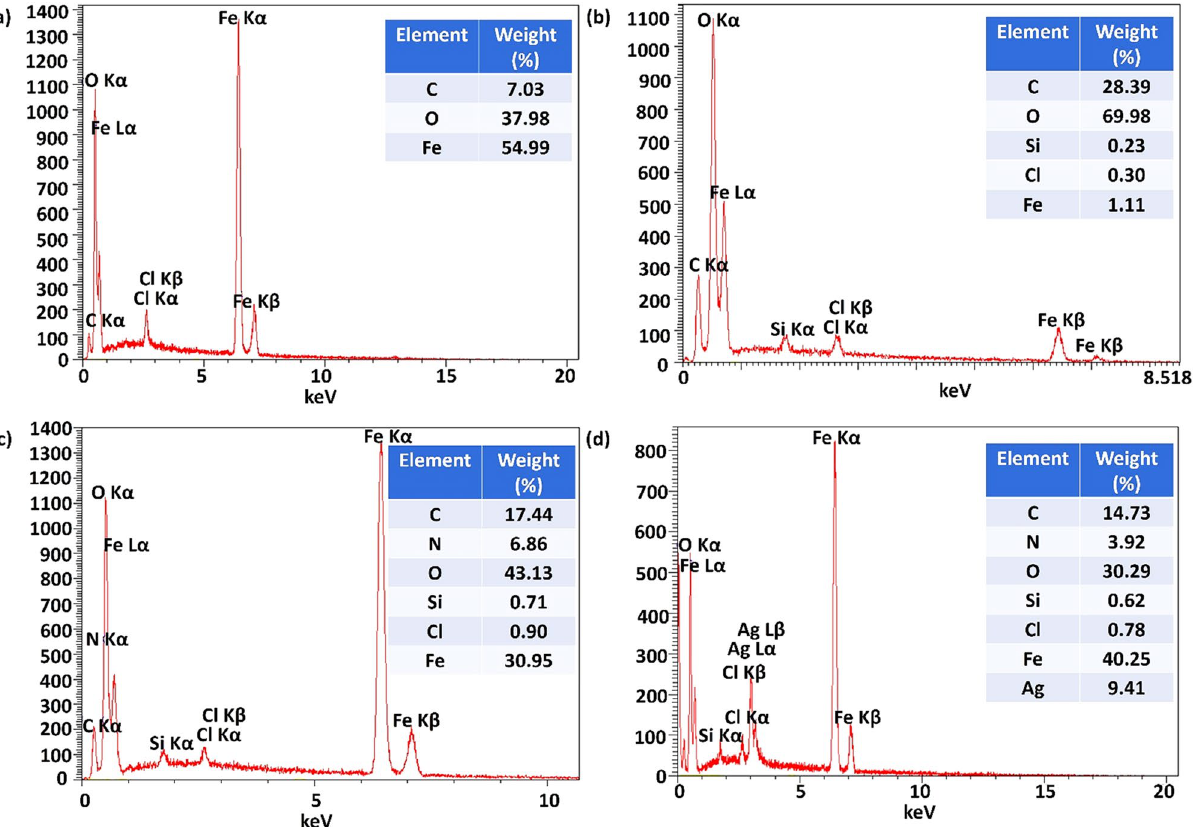
Figure 2. EDX spectra and quantitative table of the structural elements of ( a ) Fe 3 O 4 @Cur nanopowder, ( b )